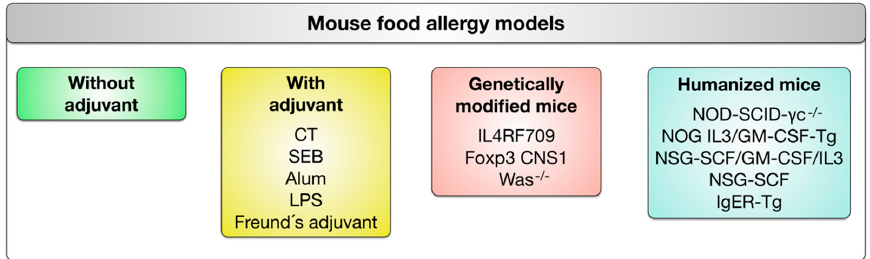
Figure 5. Classification of mouse food allergy models. The available mouse models are divided into four categories: (1) adjuvant-free mouse models, (2) mouse models relying on adjuvants to establish allergen-specific Th2 responses, (3) mouse models using genetically-modified mouse strains to allow for easier sensitization, and (4) humanized mouse models in which di ff erent immunodeficient mouse strains are reconstituted with human immune or stem cells to investigate humanized immune